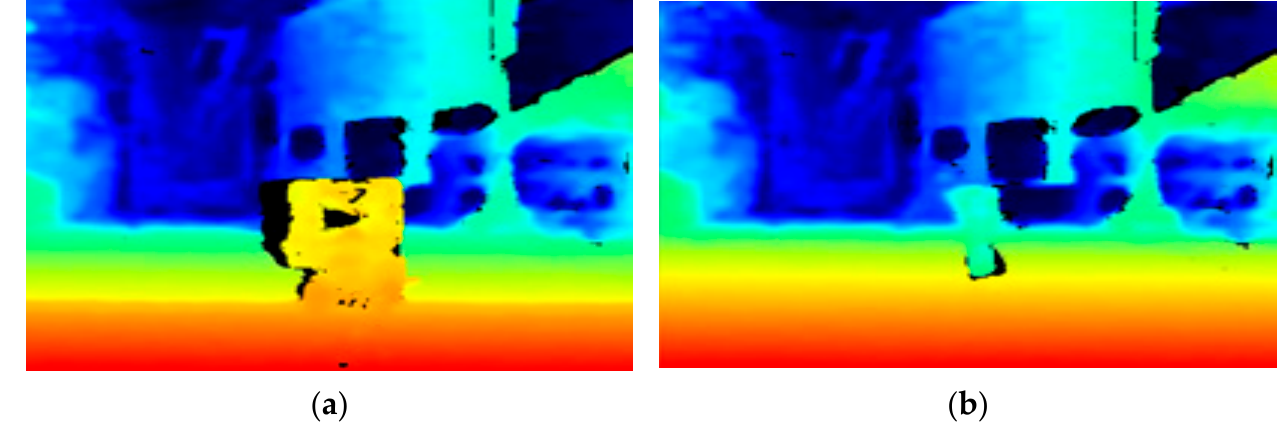
Figure 7. Depth maps at distances of: ( a ) 1000 mm; and ( b ) 3000 mm.